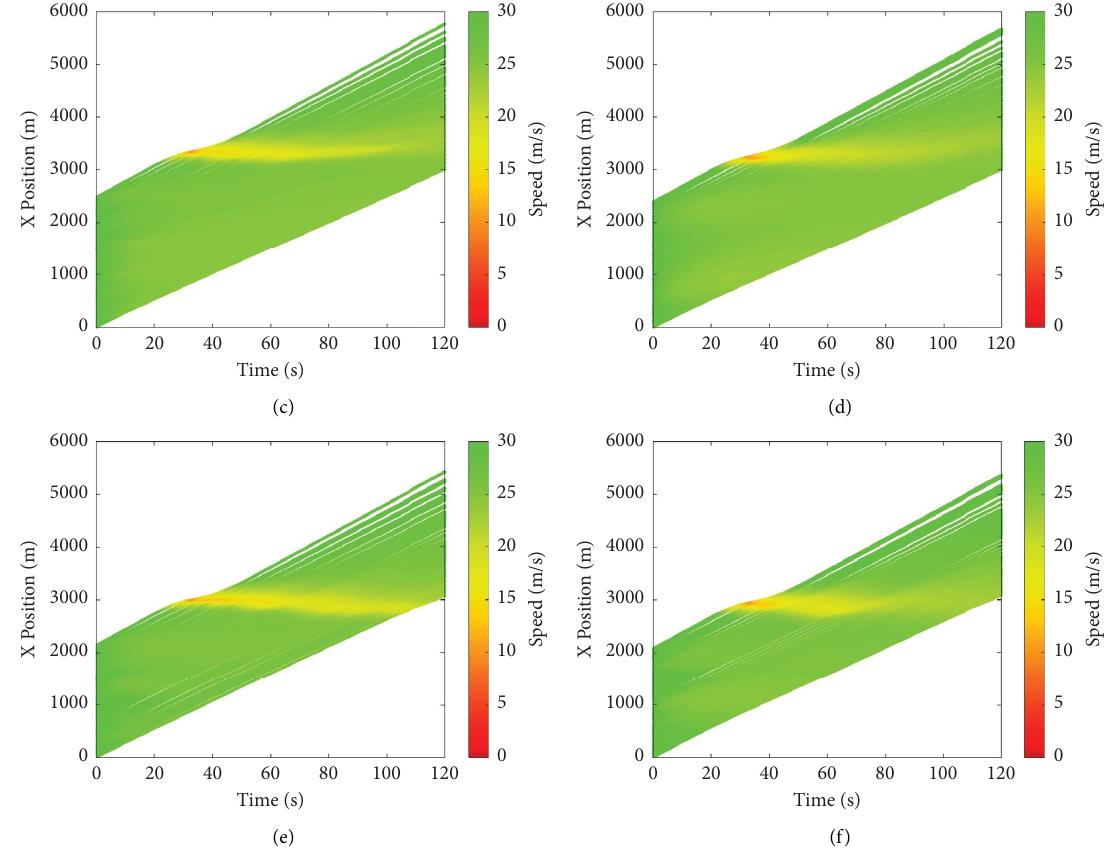
Figure 10: Vehicle spatiotemporal trajectories with diferent platoon intensities and penetration rates: (a) p � 0 . 4 , E � 0 . 2083, (b) p � 0 . 4 , E � 1, (c) p � 0 . 6 ,E � 0 . 6111, (d) p � 0 . 6 ,E � 1, (e) p � 0 . 8 ,E � 0 . 8333, and (f) p � 0 . 8 ,E �